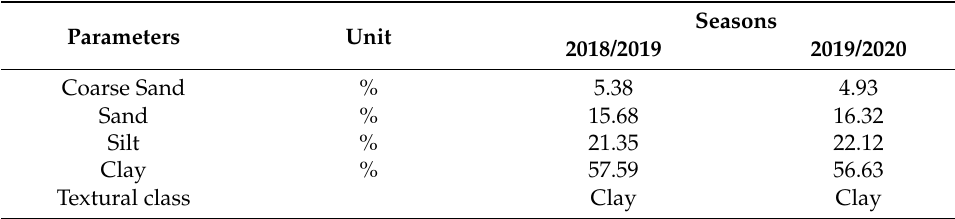
Table 1. Physical properties of the used soil.